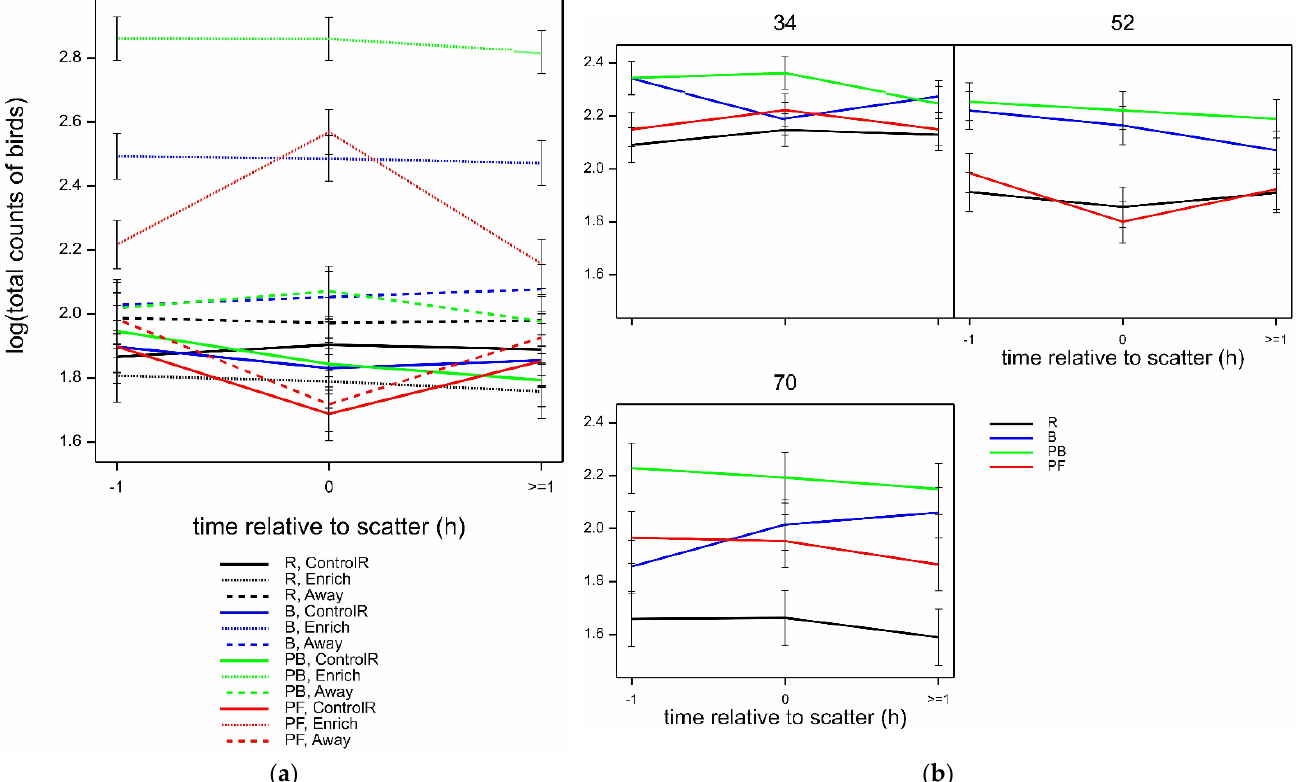
Figure 3. ( a ) Mean ± SE log (total counts of birds) observed over all behaviours in various locations (ControlR, Enrich, Away), according to enrichment treatments (R, B, PB, PF) and the time of observation relative to scatter of pelleted feed ( − 1, 0, ≥ 1), estimated from GLMM, with standard error (SE) bars shown. ( b ) Mean log (total counts of birds) observed over all behaviours with different enrichment treatments (R, B, PB, PF), according to bird age (34, 52, 70 weeks) and the time of observation relative to scatter of pelleted feed ( − 1, 0, ≥ 1), estimated from GLMM, with SE bars shown. Table 5. Mean ± SE log (total counts of birds) (back-transformed shown in parentheses) observed over all behaviours by age (34, 52, and 70 weeks) and location (ControlR, Enrich, Away), estimated from